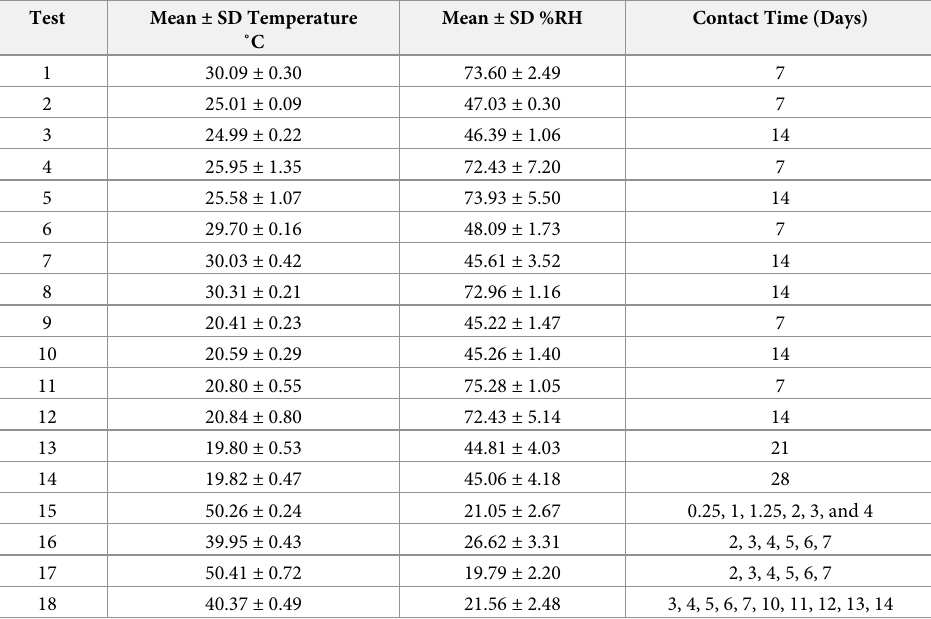
Table 1. Actual environmental conditions for attenuation